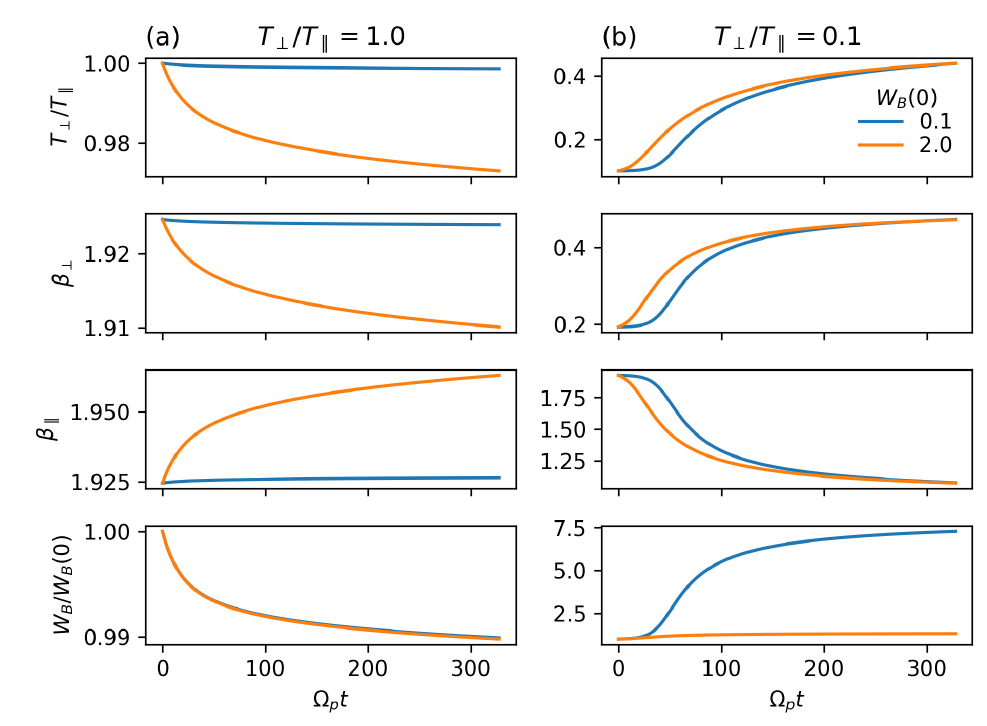
Figure 2. Time evolution of the temperature anisotropy, β ⊥ , β (cid:107) , and magnetic energy W B normalized to the initial W B ( 0 ) . The initial conditions are β (cid:107) ( 0 ) = 1.92, a magnetic spectrum with slope α = 5 and with different values of W B ( 0 ) , and ( a ) T ⊥ / T (cid:107) ( 0 ) = 1.0, and ( b ) T ⊥ / T (cid:107) ( 0 ) =